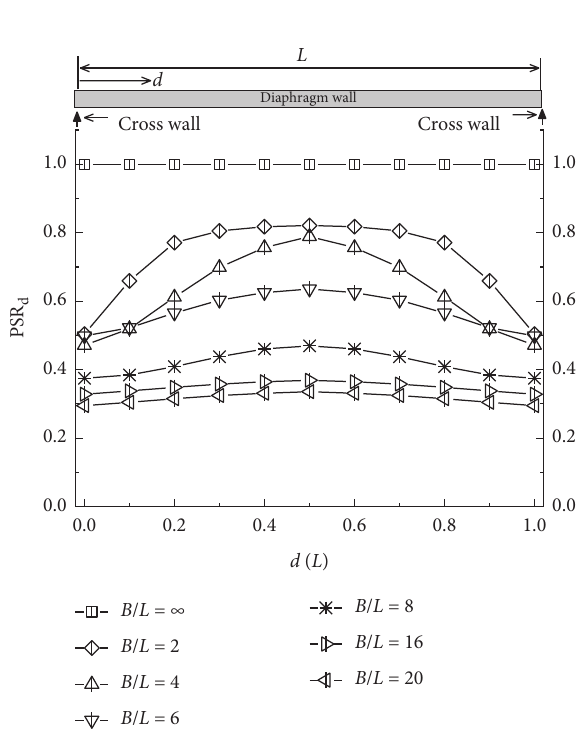
Figure 17: Relationship between PSR